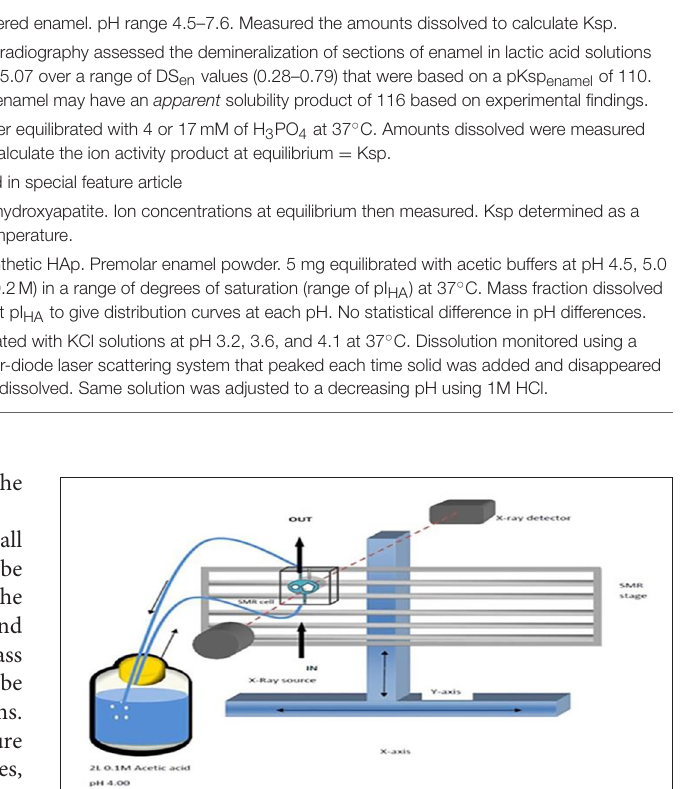
TABLE 1 | Published pKsp enamel / HAp values with references and summary of methodologies. pKsp